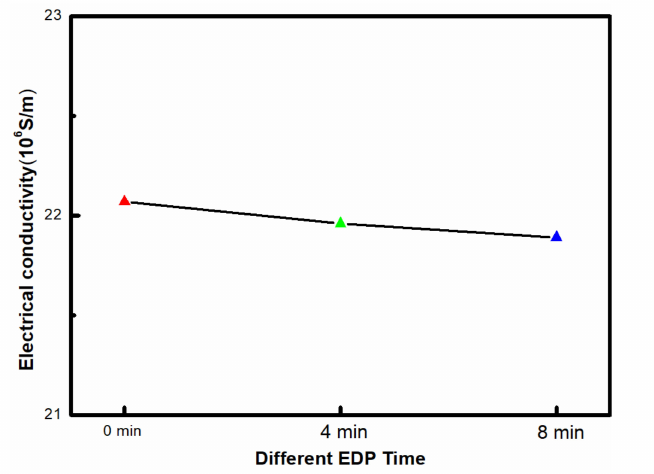
Figure 11. Electrical conductivity of the layered composites with different EPD